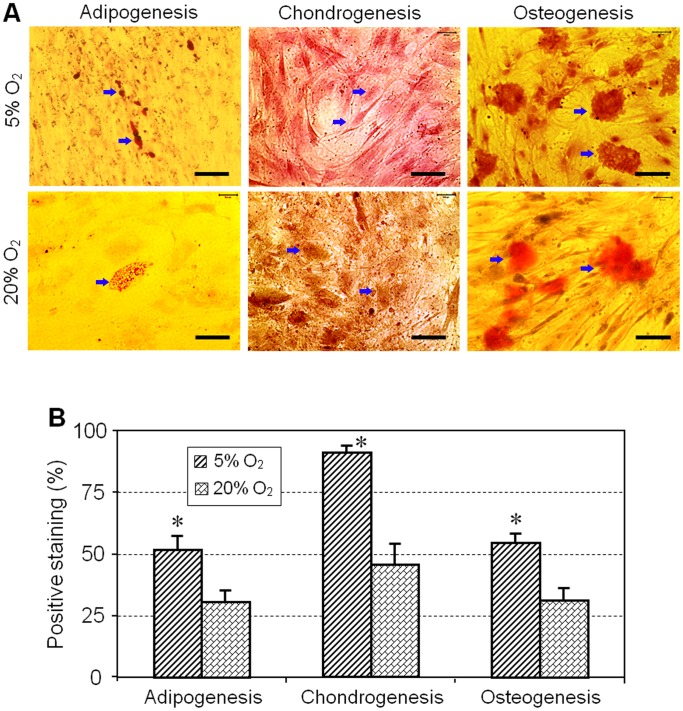
A. Multi-differentiation capacity of hTSCs under hypoxic and normaxic culture conditionshTSCs were separately grown under both hypoxic or normaxic conditions in adipogenic, chondrogenic and osteogenic induction media for 21 days followed by staining with Oil red O for adipogenesis, Safranin O for chondrogenesis and Alizarin red S for osteogenesis. It is apparent that compared to hTSCs at 20% O2 condition, cells grown at 5% O2 culture condition formed more extensive lipids, proteoglycan accumulation, and calcium deposition, as revealed by Oil red O assay, Safranin O assay, and Alizarin red S assay, respectively. Positively stained cells are indicated by arrows. Scale bars: 100 µm. B. Semi-quantification of the staining results by three assays. Positively stained cells were counted to calculate percentage staining. More hTSCs at 5% O2 condition were found to differentiate into adipocytes, chondrocytes and osteocytes than hTSCs at 20% O2 condition (*P<0.05, with respect to hTSCs that were under normaxic condition).